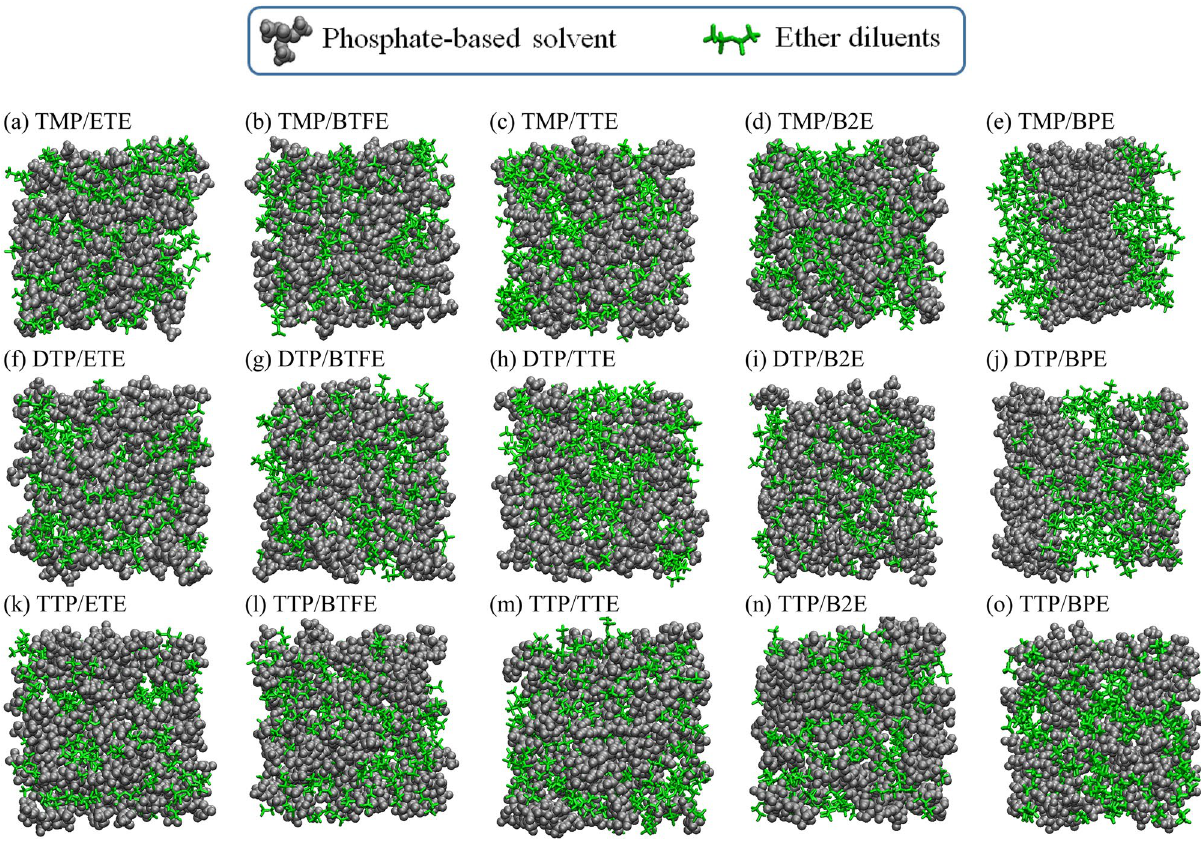
Figure 2. Snapshots of mixed solutions of ( a ) TMP/ETE, ( b ) TMP/BTFE, ( c ) TMP/TTE, ( d ) TMP/B2E, ( e ) TMP/BPE, ( f ) DTP/ETE, ( g ) DTP/BTFE, ( h ) DTP/TTE, ( i ) DTP/B2E, ( j ) DTP/BPE, ( k ) TTP/ETE, ( l ) TTP/ BTFE, ( m ) TTP/TTE, ( n ) TTP/B2E and ( o ) TTP/BPE in equilibrium state. The considered molar ratio was